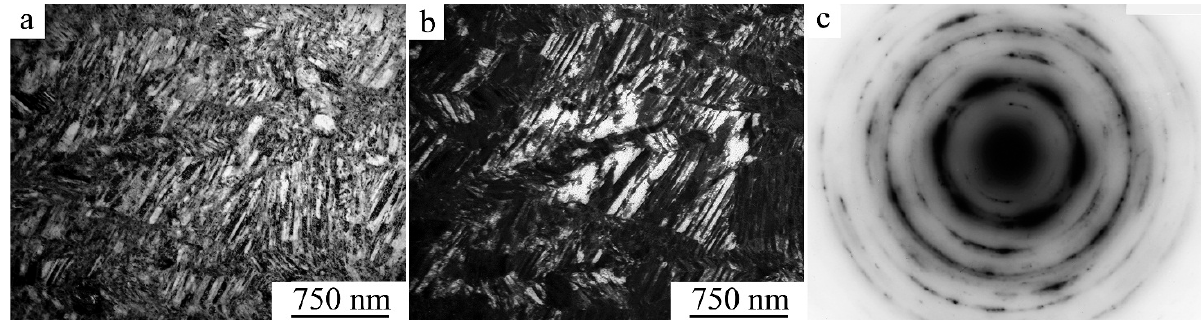
Figure 10. ( a ) Bright- and ( b ) dark-field TEM images of the microstructure, and ( c ) the corresponding ring SAED pattern (SD 0.3 µm), from the CG Ti 49.4 Ni 50.6 alloy in the neck region (cross section) [73].